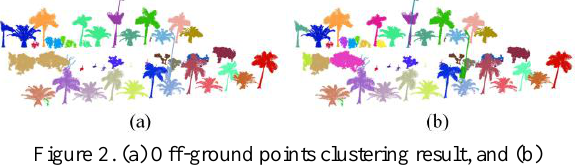
Figure 2. (a) Off-ground points clustering result, and (b) segmentation result of adjacent or overlapped